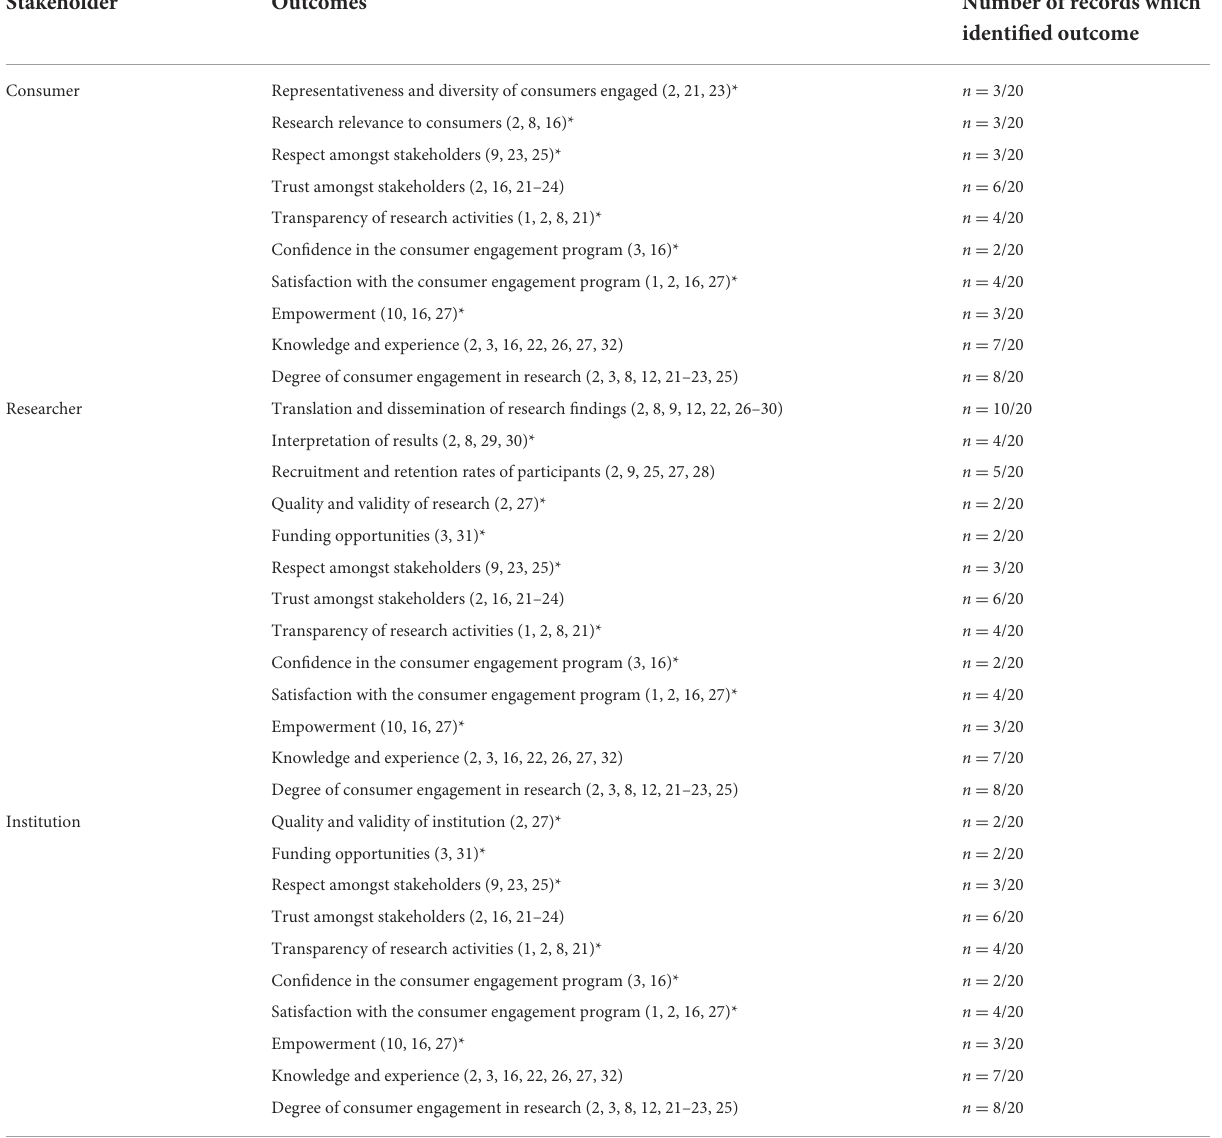
TABLE 1 Measurable outcomes of consumer engagement categorized relevant to